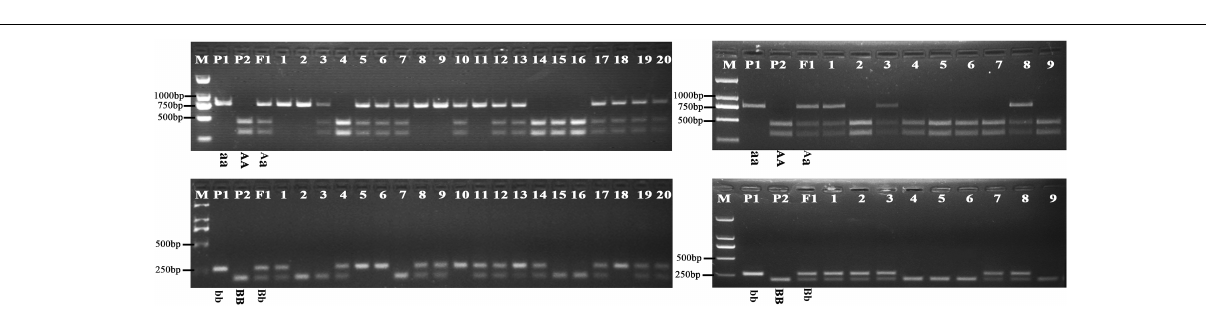
FIGURE 5 | Genotyping of the segregation lines using CAPS markers. The genotype of each line is shown under its enzyme-digested band. The left panel shows the band types for the P1, P2, F1, and F2-1 populations digested by BssS α I (upper) and HinfI (lower) restriction enzymes, and no. 1–20 refer to the single lines from the F2-1 population. The right panel shows the band types for the P1, P2, F1, and BC1-1 populations digested by BssS α I (upper) and HinfI (lower) restriction enzymes, and no.1-9 refer to the single lines from the BC1-1 population. M, DNA marker; P1, mutant line N1379T; P2, normal line 16wh53. The 60, 80, and 58 bp bands produced by HinfI appear as a single band on the gel because of their very similar lengths; however, these could be differentiated during our analysis. There were three standard bands in the M lane representing the 750, 500, and 250 bp band